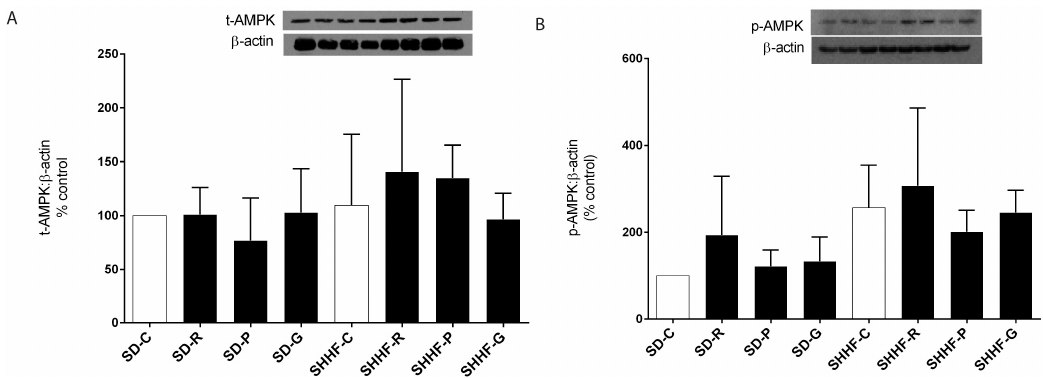
Figure 6. Lack of effect of stilbenoid treatment on AMPK in SD and SHHF rat hearts. No differences in ( A ) total AMPK levels nor ( B ) AMPK α activation (vis-à-vis phosphorylation at Thr172) were detected between SD and SHHF rat hearts, in the presence or absence of stilbenoid treatment. n = 5.